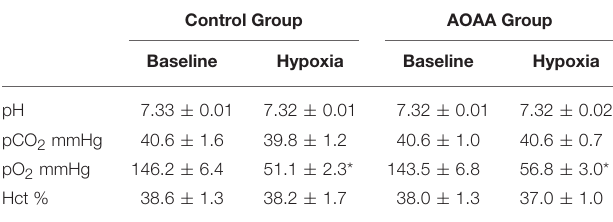
TABLE 1 | Values of arterial pH, pCO 2 , pO 2 and hematocrit of rats in the control and AOAA groups taken under room air and hypoxia exposure. Control Group AOAA Group Baseline Hypoxia